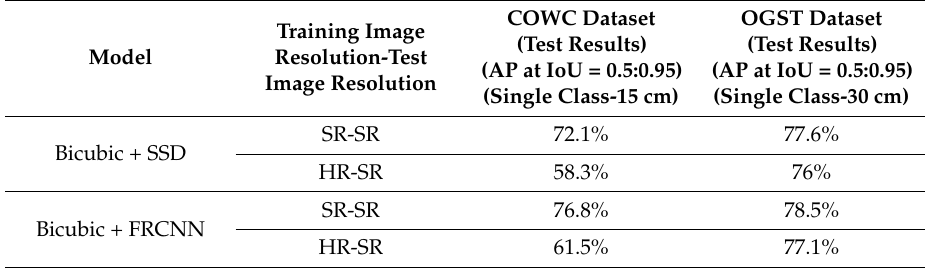
Table 2. Detection on SR (super-resolution) images with separately trained SR network. Detectors are trained with both SR and HR (high-resolution) images and AP (average precision) values are calculated using 10 different IoUs (intersection over